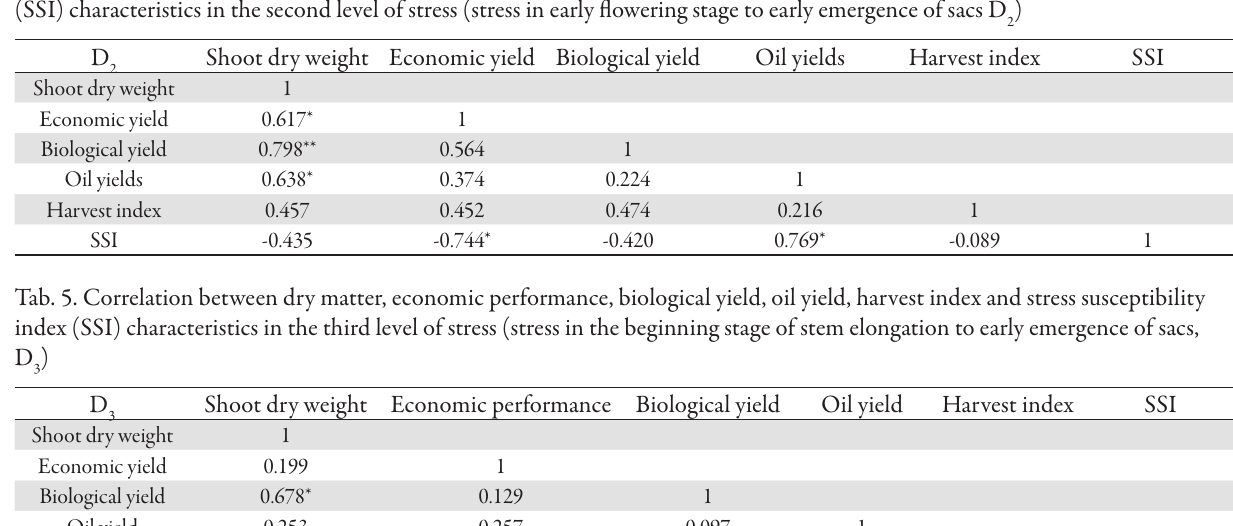
Tab. 4. Correlation between dry matter, economic yield and biological seed and oil, harvest index and stress susceptibility index (SSI) characteristics in the second level of stress (stress in early flowering stage to early emergence of sacs D